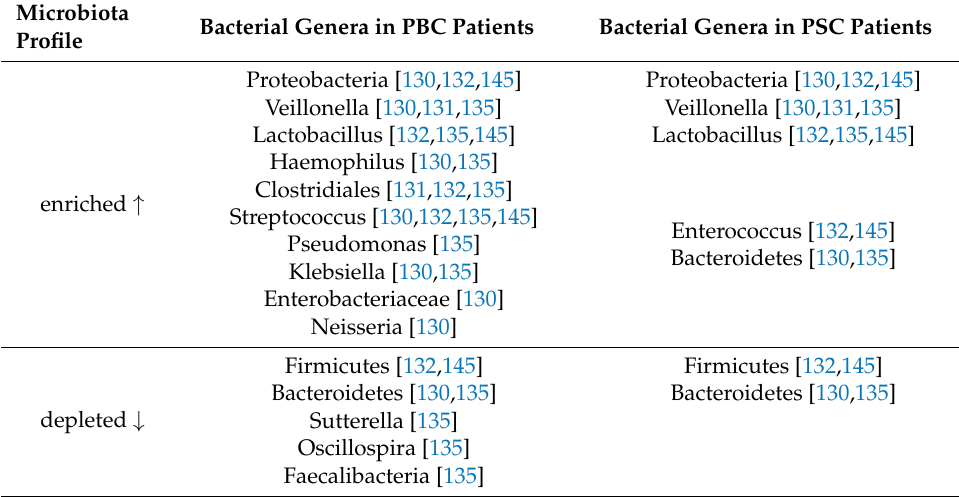
Table 2. Changes in gut and oral microbiome profiles in PBC and